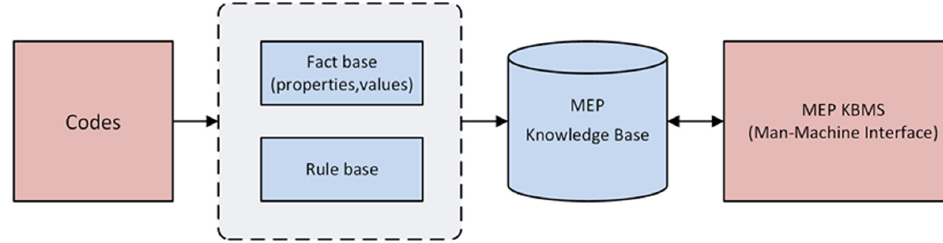
Figure 2. Creation process of the MEP KBMS.